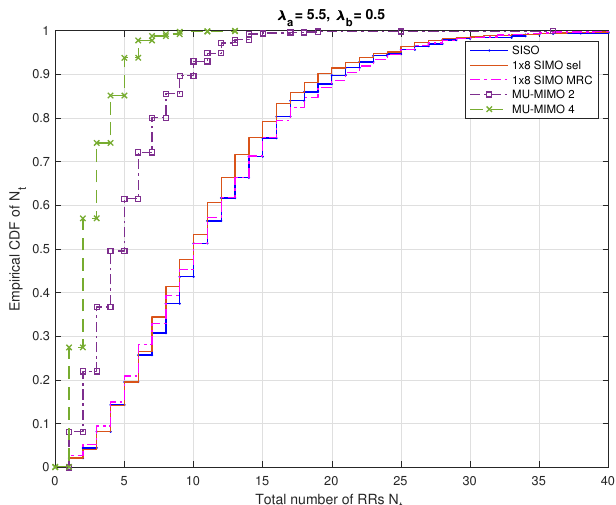
Figure 7. The empirical Cumulative Distribution Function (CDF) of N t total number of RRs required for the typical cell in which the maximal delay τ max = 1 ms, λ a = 5.5 nodes/km 2 and λ b = 0.5 nodes/km 2 .